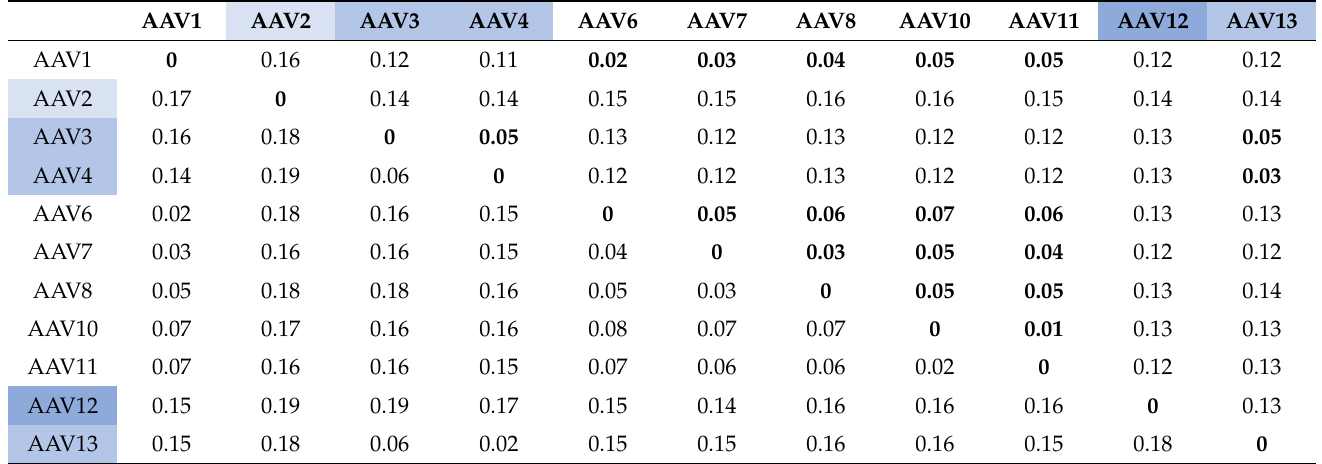
There were no virus pairs in the dataset that were assigned to the same serotype, but four distinct rep genotypes could be identified (Table 2, Figure